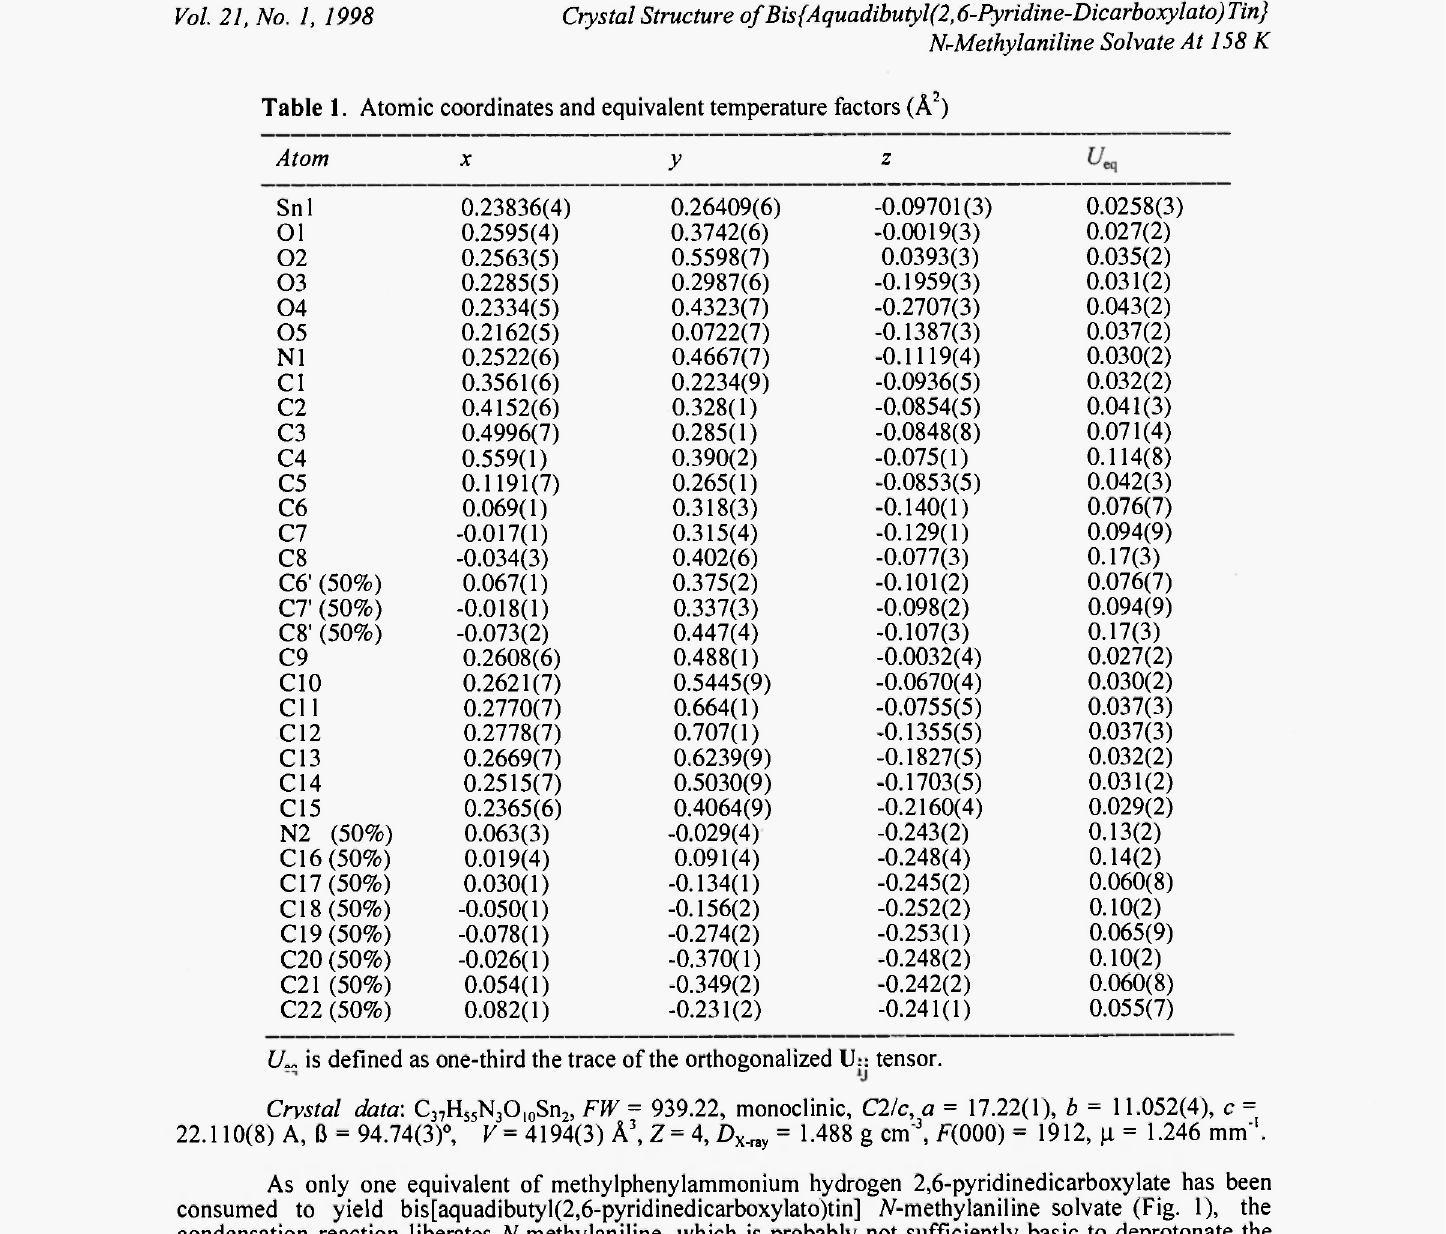
Table 1. Atomic coordinates and equivalent temperature factors (A 2